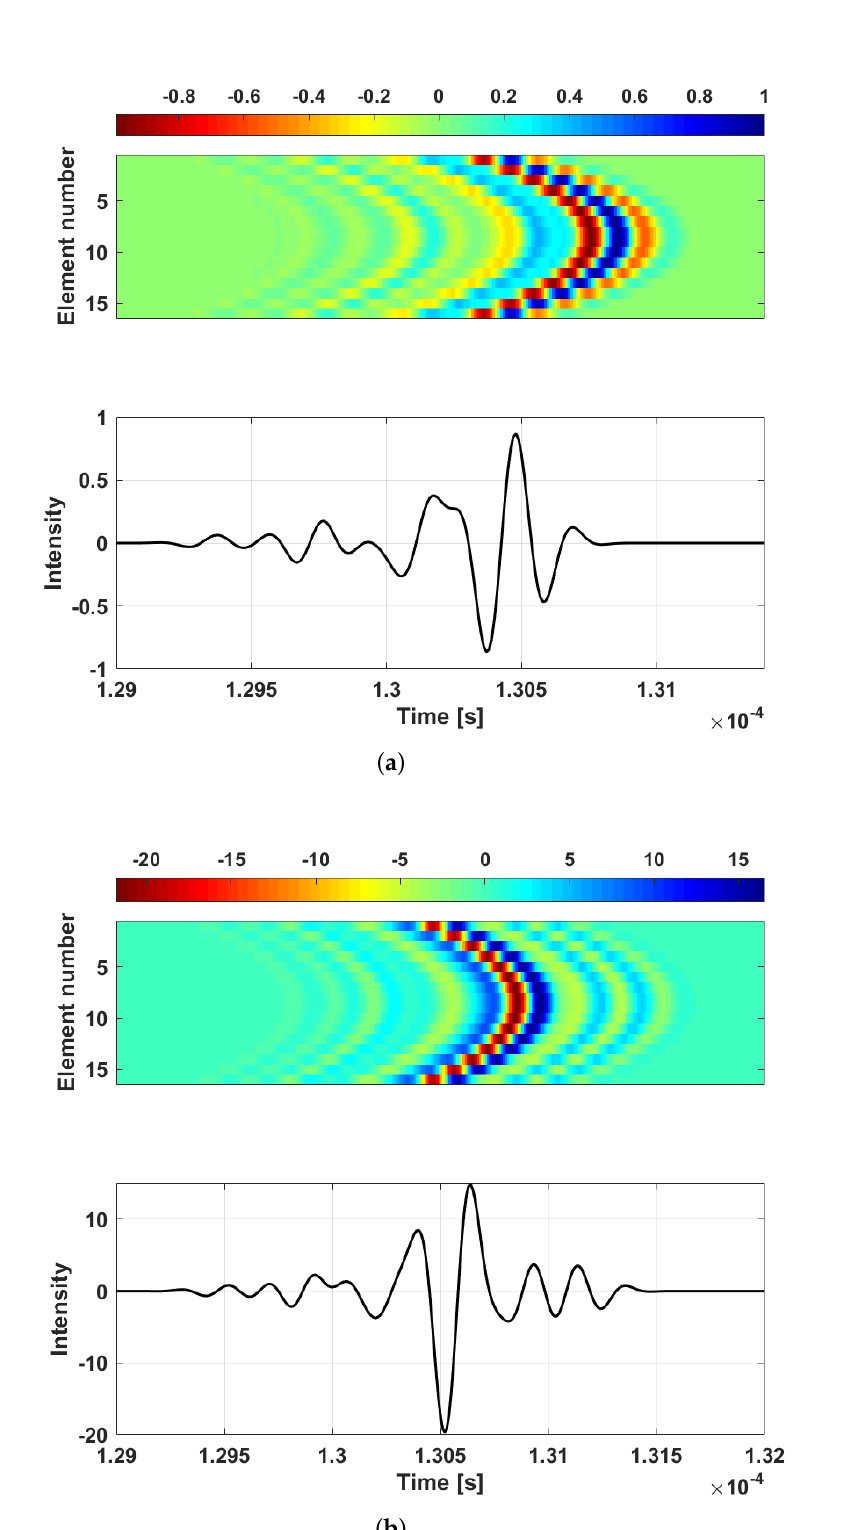
Figure 8. The 7-length Barker code simulation result. ( a ) The original received intensities from the individual elements of a linear array transducer (top) and the individual response of center element (bottom). ( b ) The compressed signals from the individual elements of a linear array transducer (top) and the compressed signal of center element